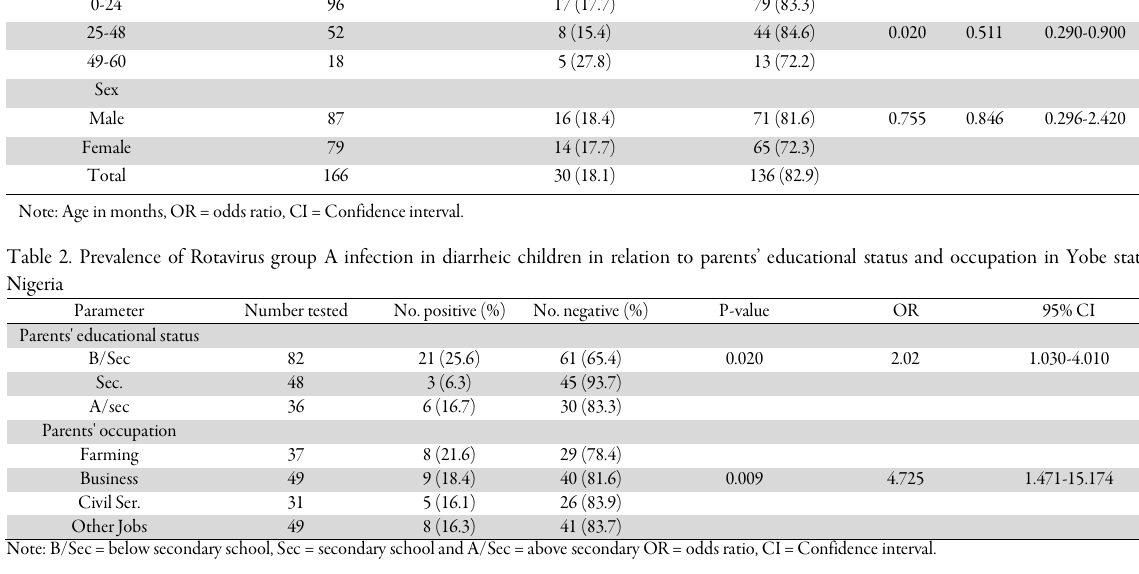
Table 3. Prevalence of Rotavirus infection in diarrheic children in relation to water sources and food types in Yobe state, Nigeria